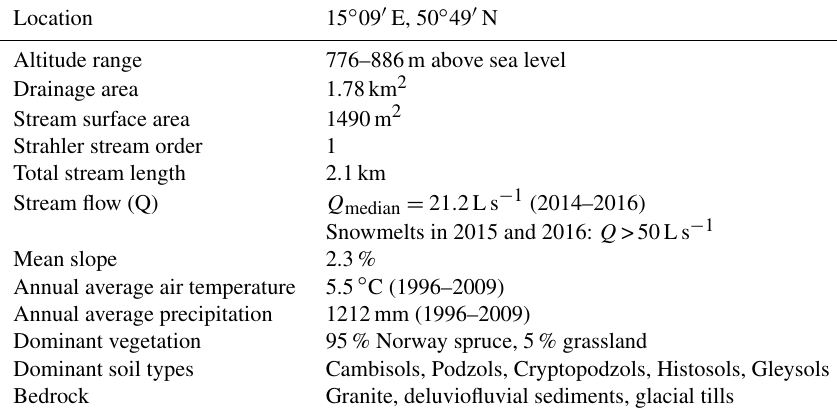
Table 1. Characteristics of the Uhlíˇrská catchment and ˇCerná Nisa